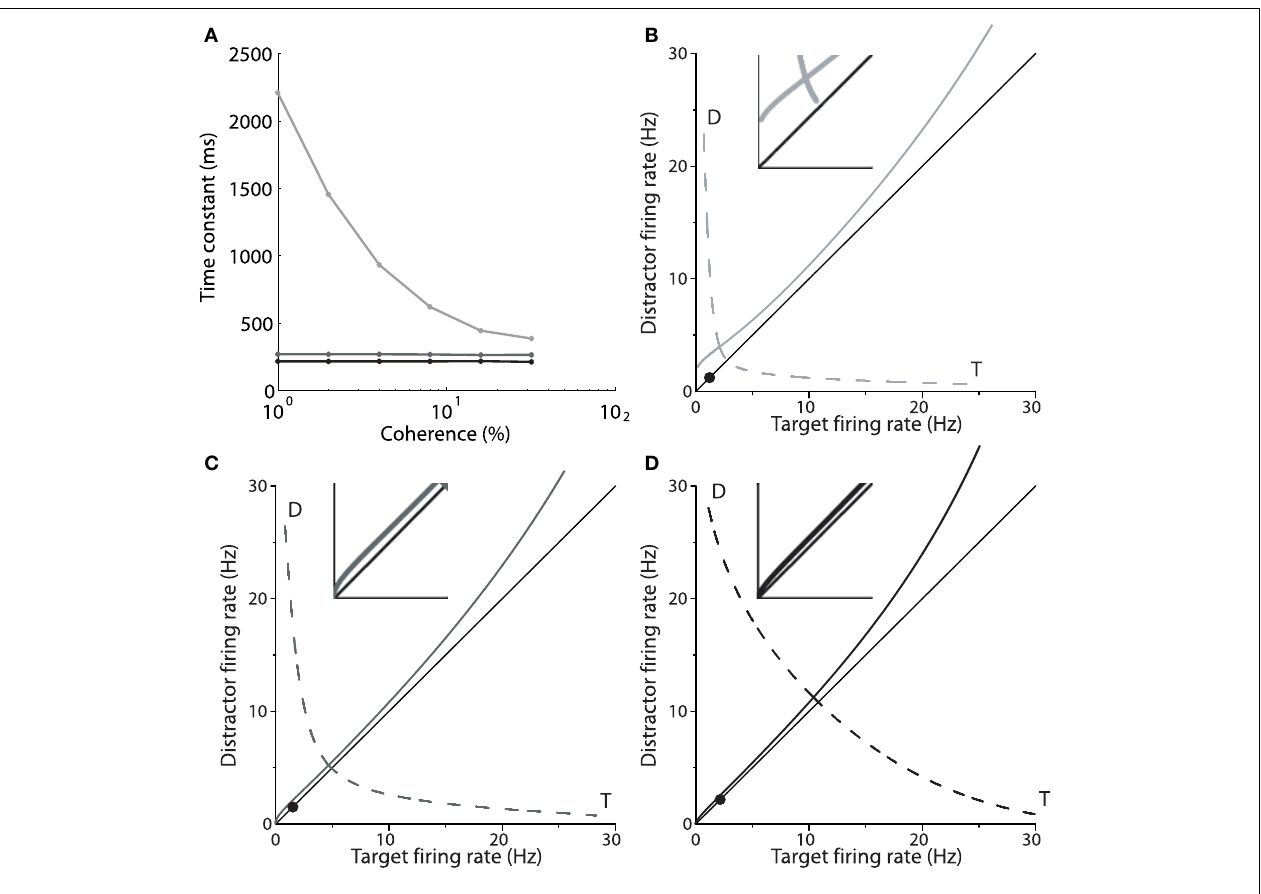
FIGURE 4 | (A) The time constant of the unstable manifold of the saddle point (see Figure 1 ) for speed (black), neutral (medium gray) and accuracy (light gray) conditions, as a function of coherence. The time constant determines the time over which the system is repelled from the saddle toward an attractor corresponding to the target or the distractor ( Figure 1C ; T and D in B–D ). (B–D) Stable (solid) and unstable (dashed) manifolds of the